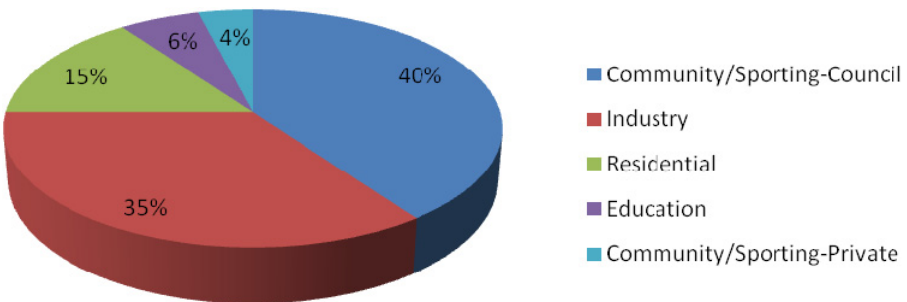
Figure 1. Distribution chart of Salisbury Water